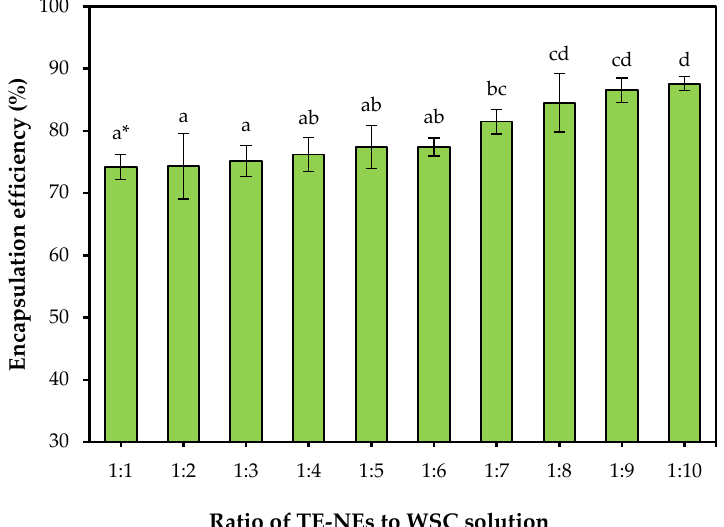
Figure 3. Effect of the TE-NEs/chitosan ratio on the encapsulation efficiency of the WCS-TE-NEs. * Different letters indicate significant differences at p < 0.05 by Duncan’s multiple range test.